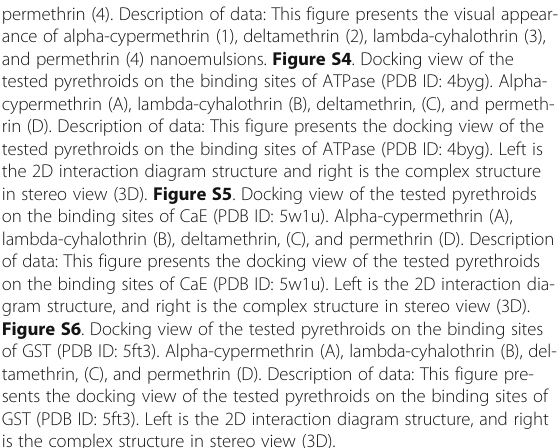
Figure S6 . Docking view of the tested pyrethroids on the binding sites of GST (PDB ID: 5ft3). Alpha-cypermethrin (A), lambda-cyhalothrin (B), del- tamethrin, (C), and permethrin (D). Description of data: This figure pre- sents the docking view of the tested pyrethroids on the binding sites of GST (PDB ID: 5ft3). Left is the 2D interaction diagram structure, and right is the complex structure in stereo view